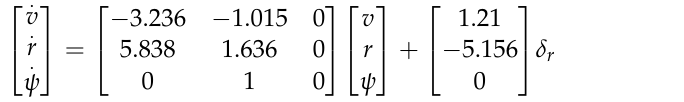
The heading plane control loop depicted in Figure 3 states that the inner control loop governs the autonomous underwater vehicle’s rudder angle, while the outer control loop governs the heading angle.